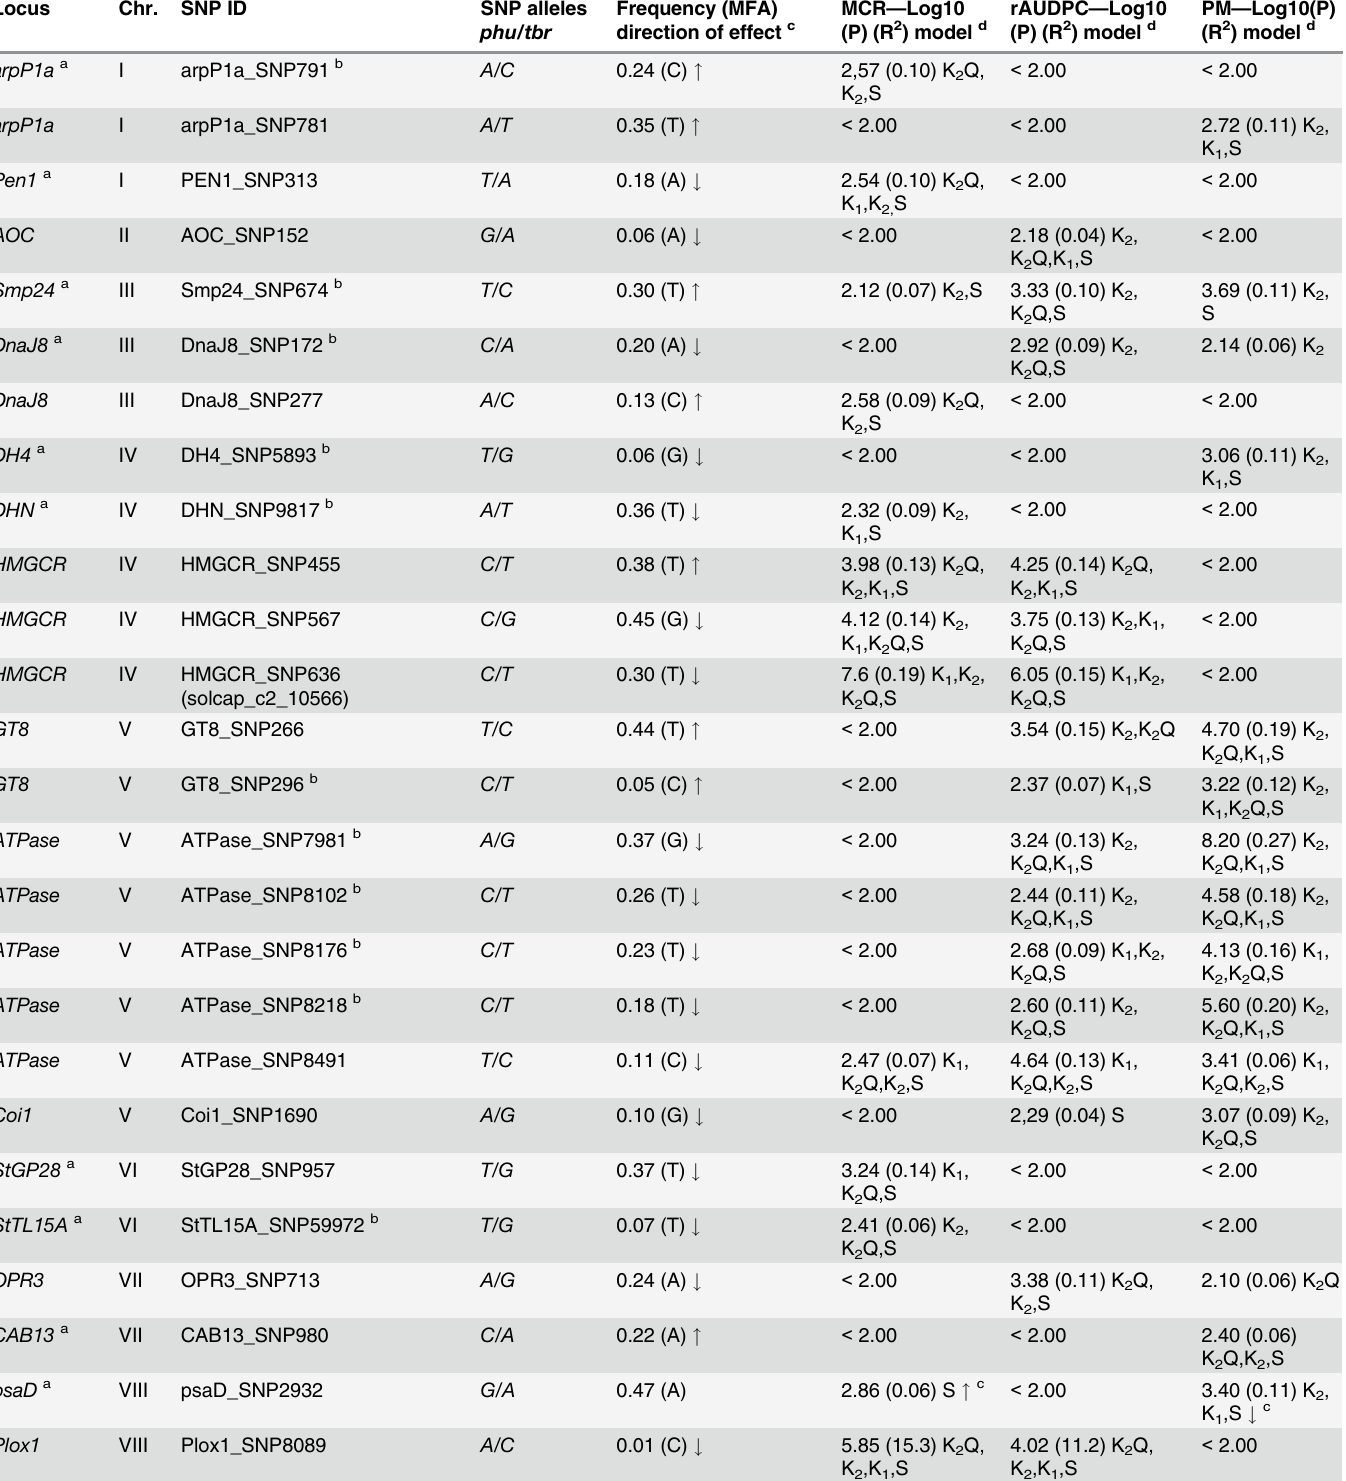
Table 2. SNPs in candidate genes showing association with rAUDPC, MCR and/or PM in three or four association models with -Log10(P) > 2. Full data are available in S4 – S6 Files.